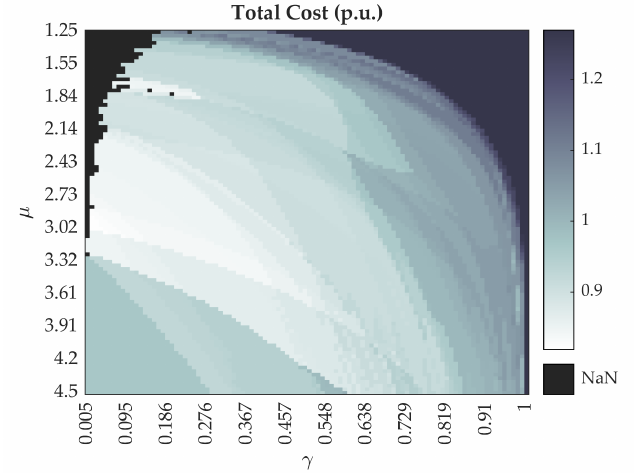
Figure 3. Heatmap of the total cost dependency on the input